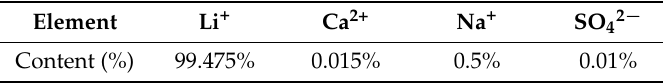
Table 3. The composition of lithium bicarbonate